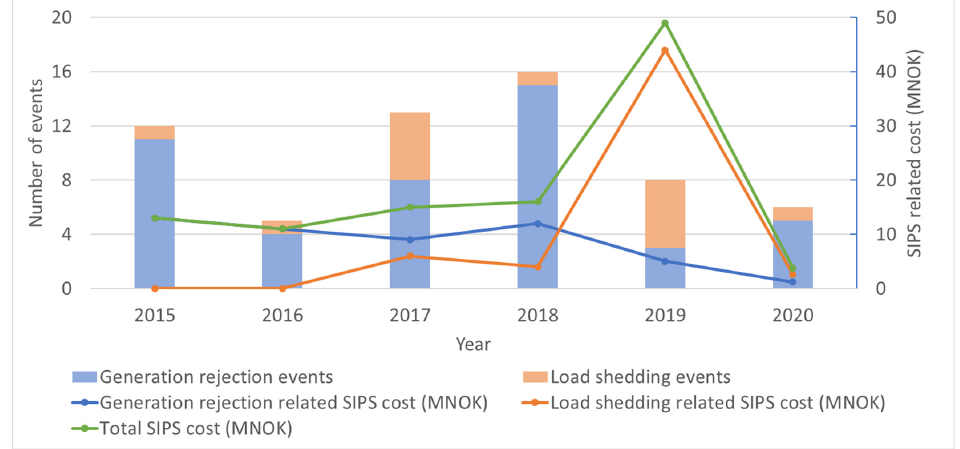
Figure 3. Number of load shedding and generation rejection events as well as SIPS-related costs for